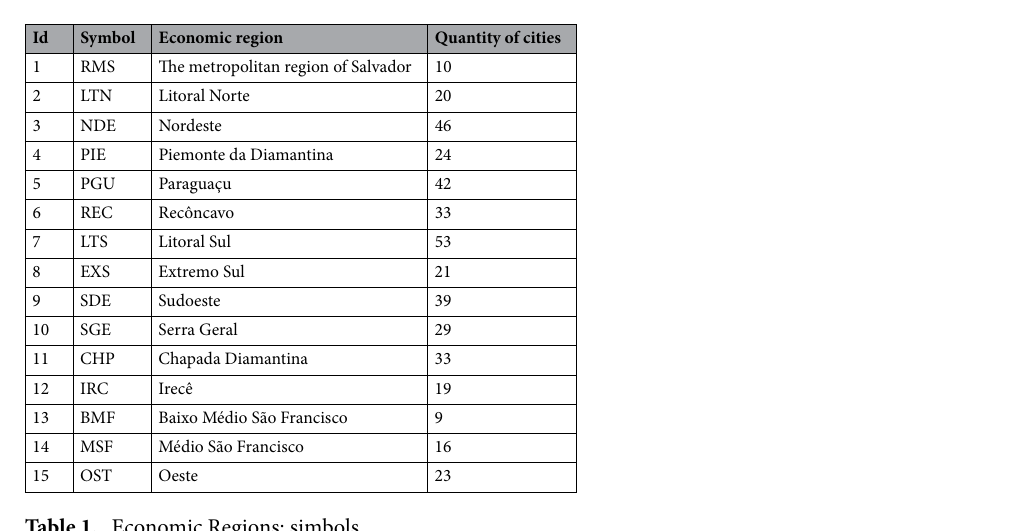
Table 1. Economic Regions: